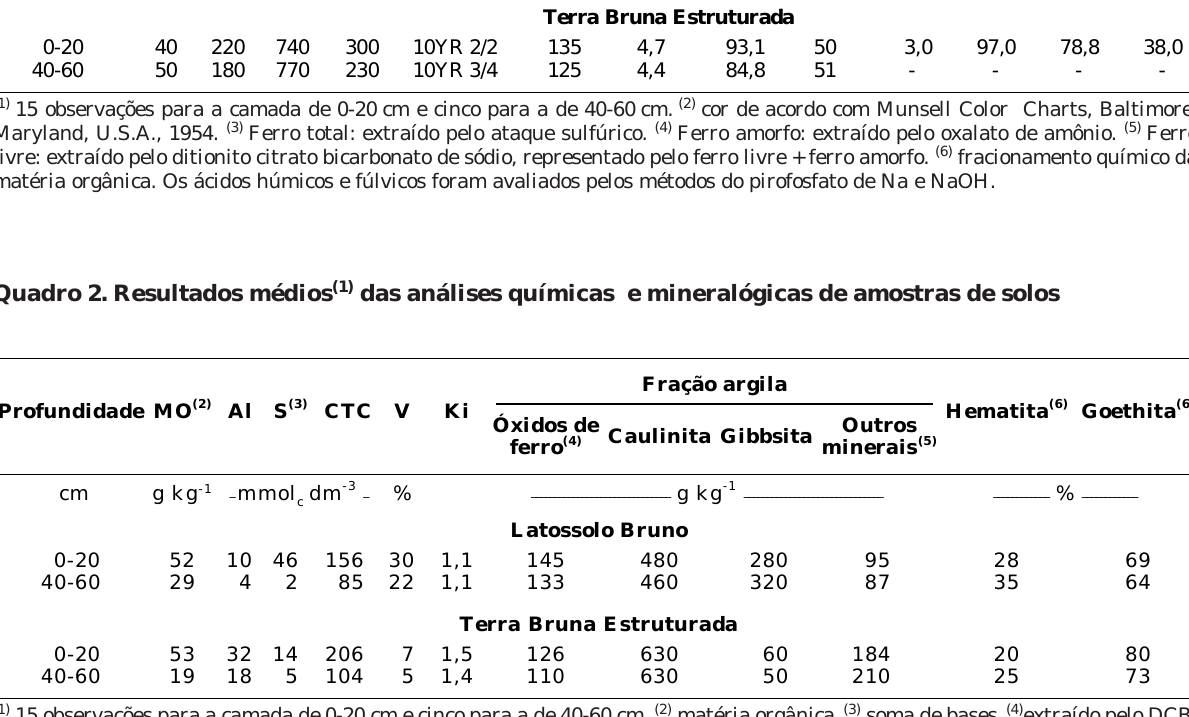
livre: extraído pelo ditionito citrato bicarbonato de sódio, representado pelo ferro livre + ferro amorfo. (6) fracionamento químico da matéria orgânica. Os ácidos húmicos e fúlvicos foram avaliados pelos métodos do pirofosfato de Na e NaOH.